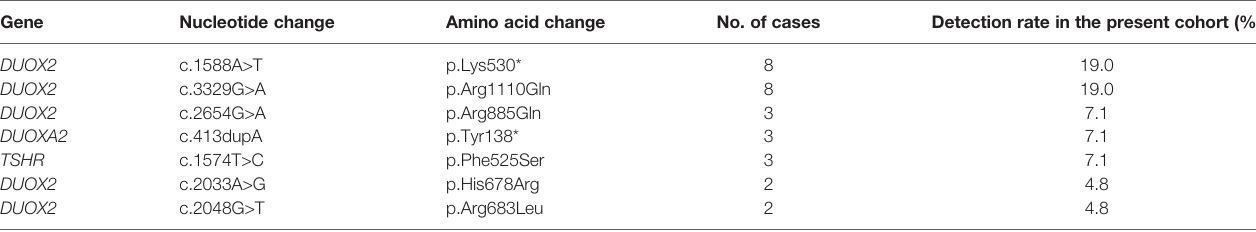
TABLE 2 | Variants detected in multiple participants.